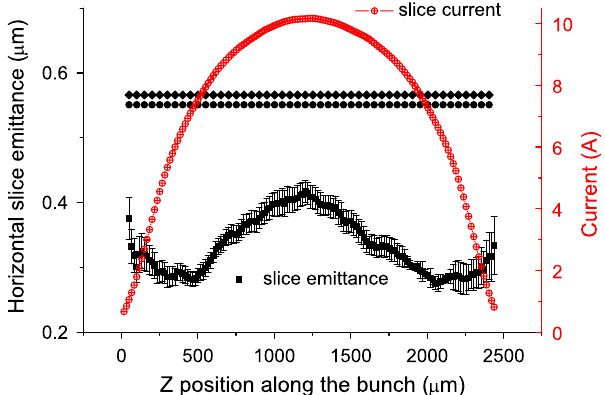
FIG. 16. Horizontal slice emittance and slice current for a 60 pC uncompressed beam. Black triangles (diamond) show the relative measured horizontal (vertical) projected emittance.